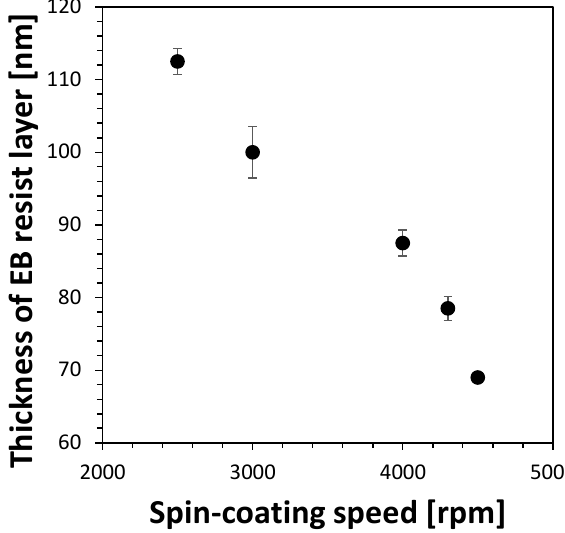
Figure 2. Relationship of the thickness of EB resist layer vs. spin-coating speed.